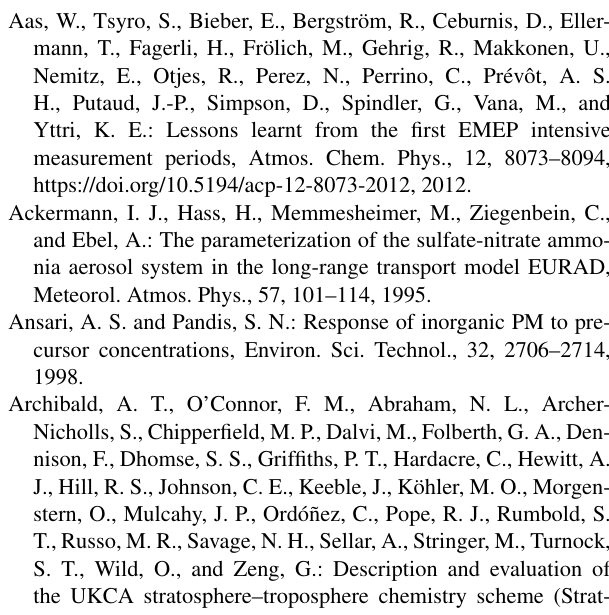
Figgans, G., and Carslaw, K. S.: Size-resolved simulations